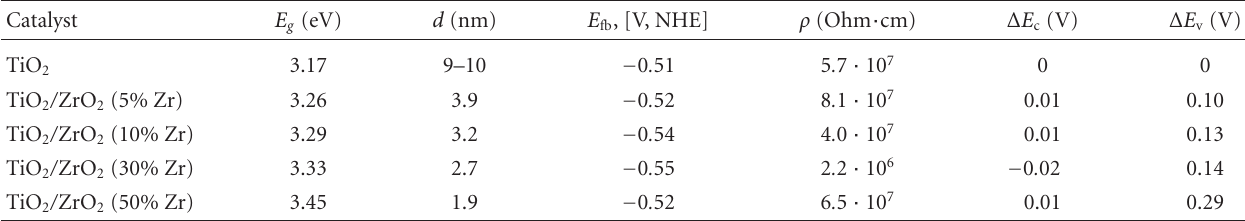
Figure 2: (a) ( η · h ν ) 2 = f ( h ν ) dependence for TiO 2 / ZrO 2 film: 1–5; 2–10; 3–30; 4–50% of ZrO 2 . E = 0 . 28V (NHE). (b) Photocurrency ( i ph ) changes plotted against applied potential (versus NHE) for TiO 2 / ZrO 2 films: 1–10% Zr; 2–50% Zr content. Table 2: Photoelectrochemical characteristics for TiO 2 / ZrO 2